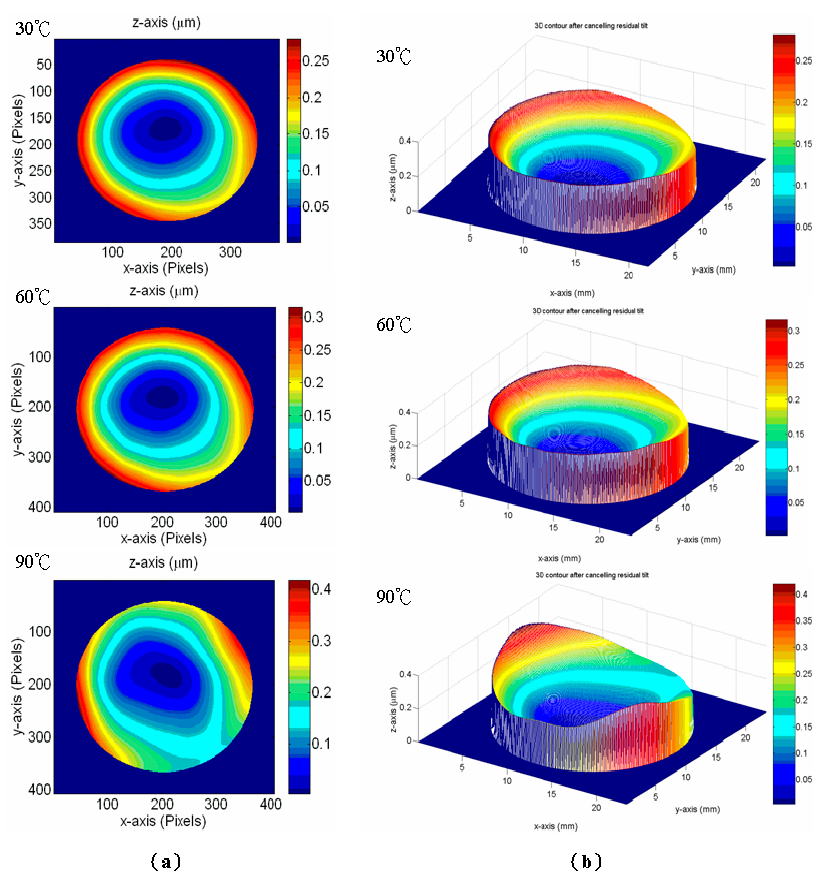
Figure 4. Surface profile changes of the ITO film deposited on the S-TIM35 glass substrate in the heating temperature range of 30–90 °C. ( a ) Two-dimensional profile. ( b ) Three-dimensional surface topography.